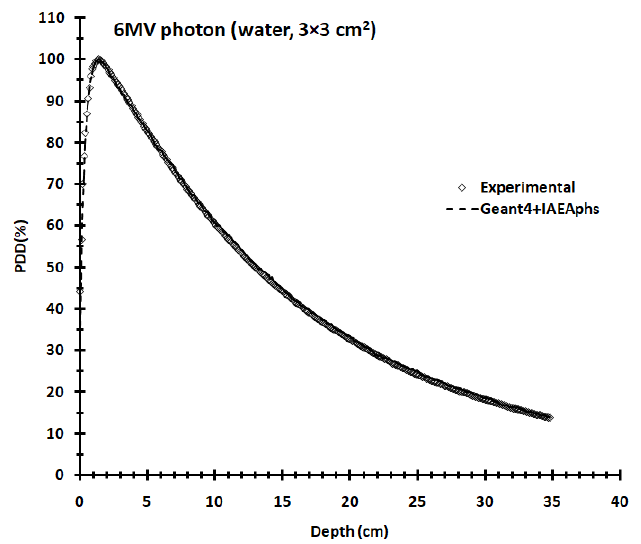
Figure 2. Comparison of Geant4-simulated (based on IAEA phase space file) and experimental PDD data for a 6 MV photon beam (field size of 3 × 3 cm 2 ) within